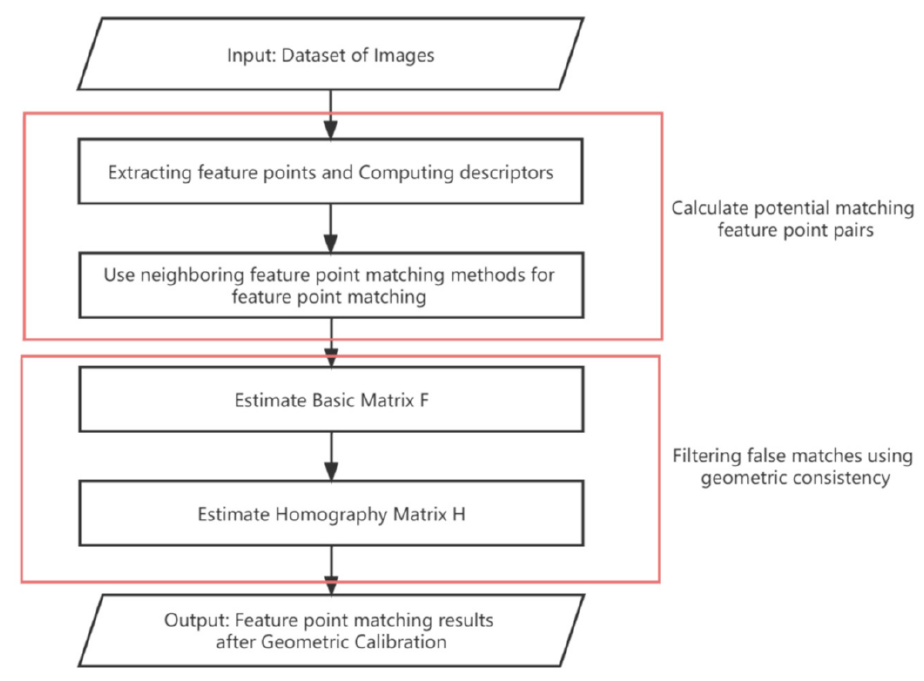
Figure 4. The pre-processing process.